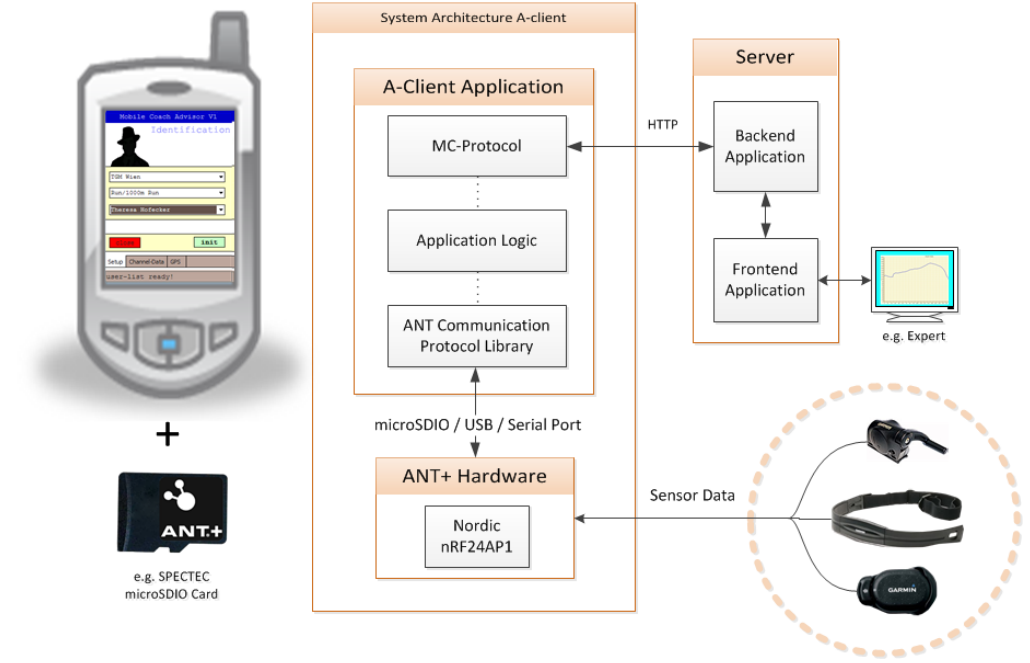
Figure 3. Architecture of the A-Client.